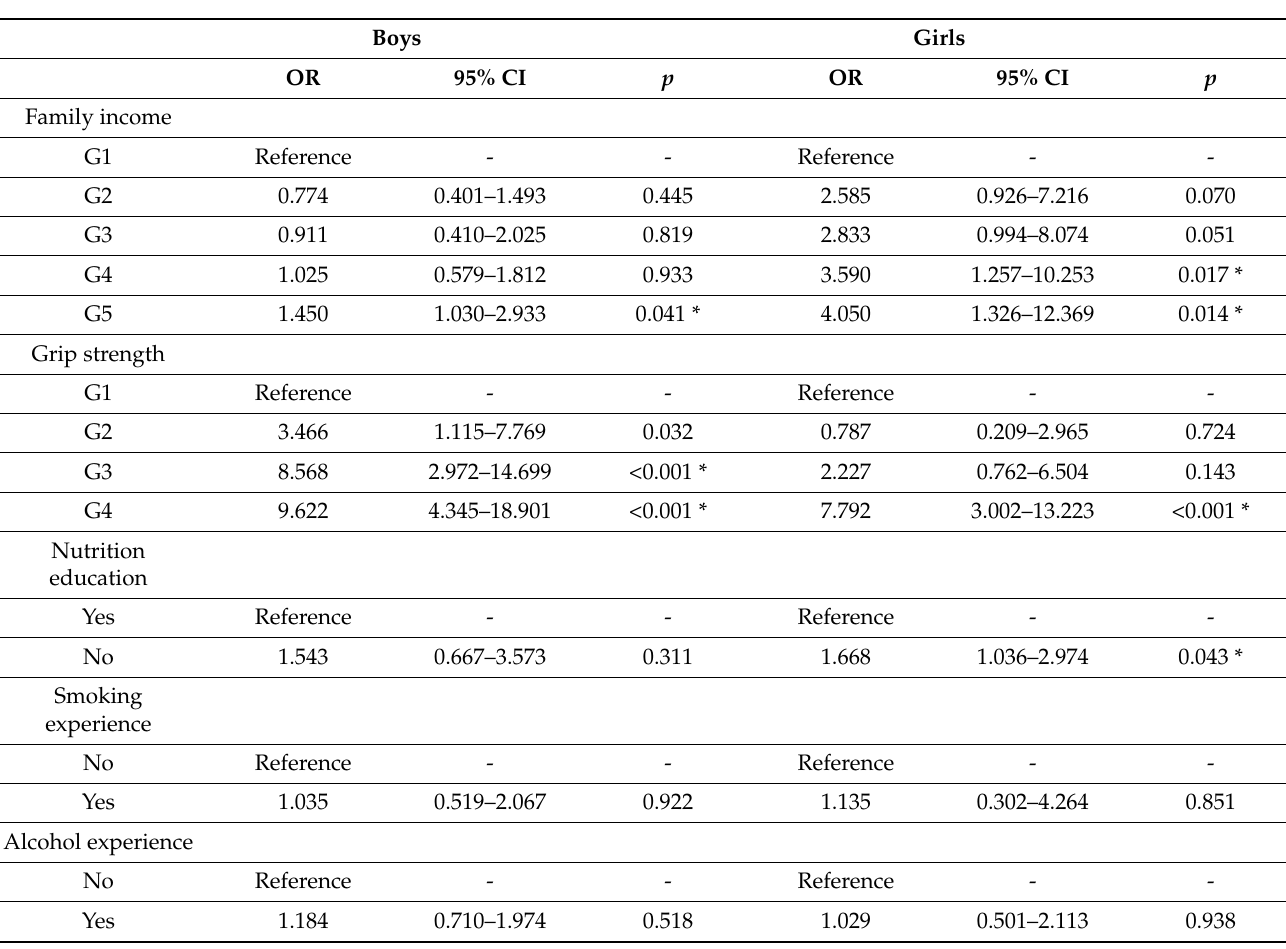
Table 3. Metabolic syndrome odds ratio according to household income, grip strength and health